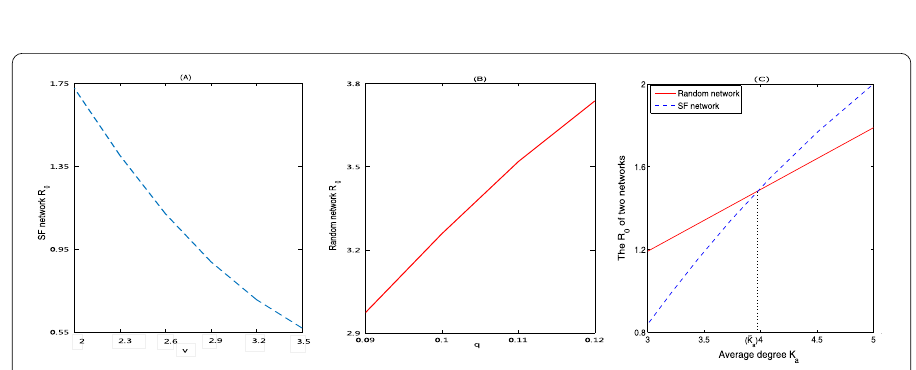
(cid:18) M k =1 I k ( t )) on the whole random network with